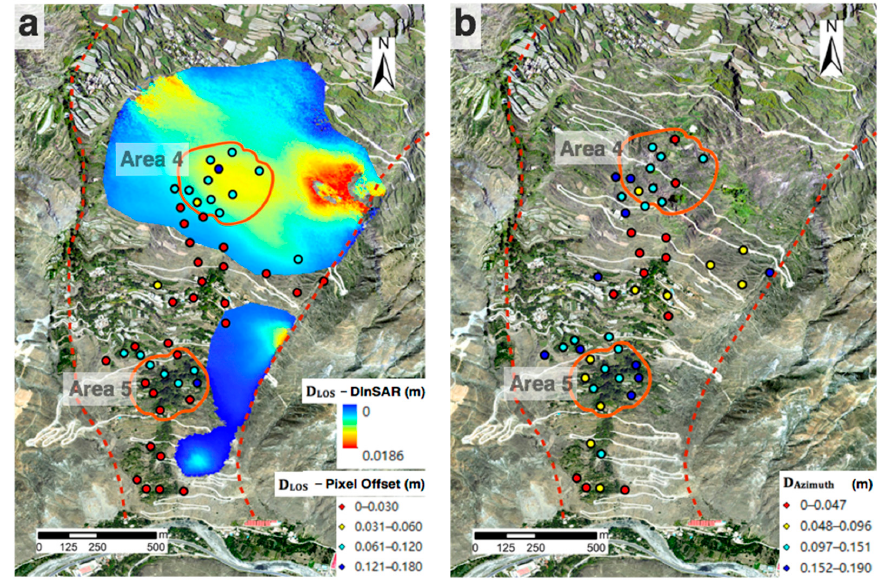
Figure 5. Slant range displacements ( a ) and azimuth displacements ( b ) measured from 21 November 2014 to 11 March 2015. Table 4. LOS displacements and corresponding differences between ten points in Area 4 derived from DInSAR processing and offset tracking processing.